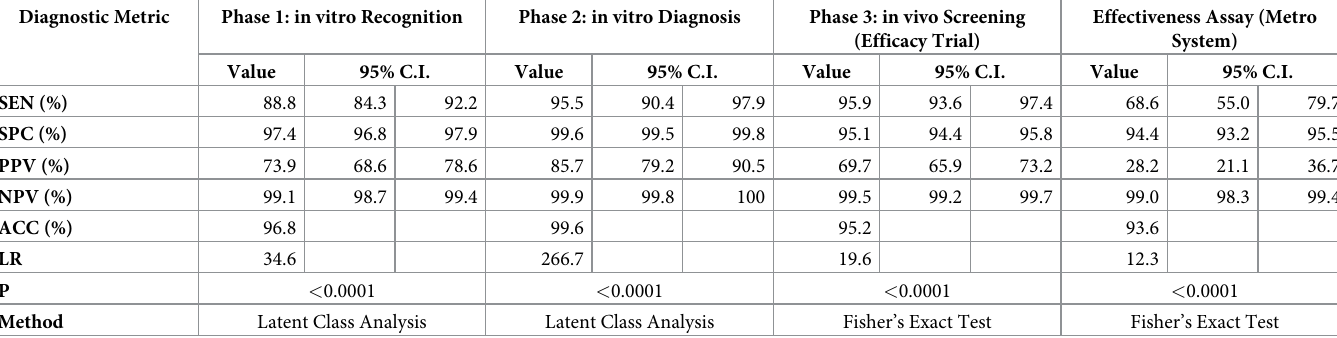
Table 3. Summary of the results attained with six dogs trained to detect COVID-19 by scenting saliva and the body of human participants.